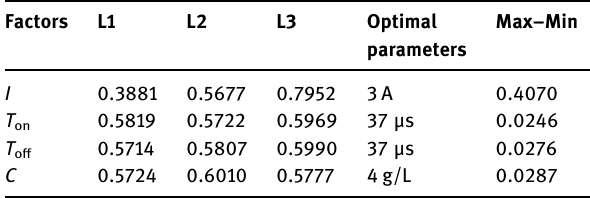
Table 5: Computation of optimal process parameters combination Factors